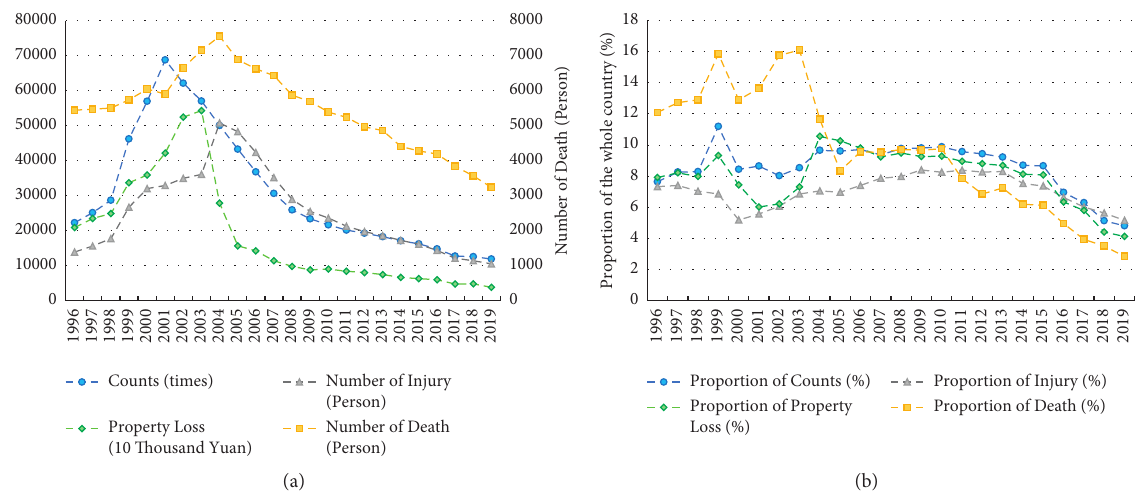
Figure 2: The number and proportions of traffic accidents in Zhejiang Province (1996–2019). (a) The number of traffic accidents. (b) The proportions of traffic accidents.